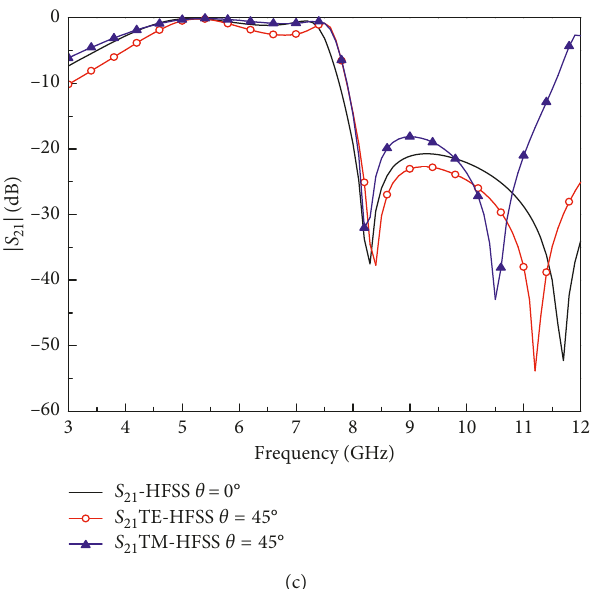
Figure 7: The simulated results using the ECM and HFSS. (a) | S ( θ � 45 ° ) for TE/TM polarization. (c) | S